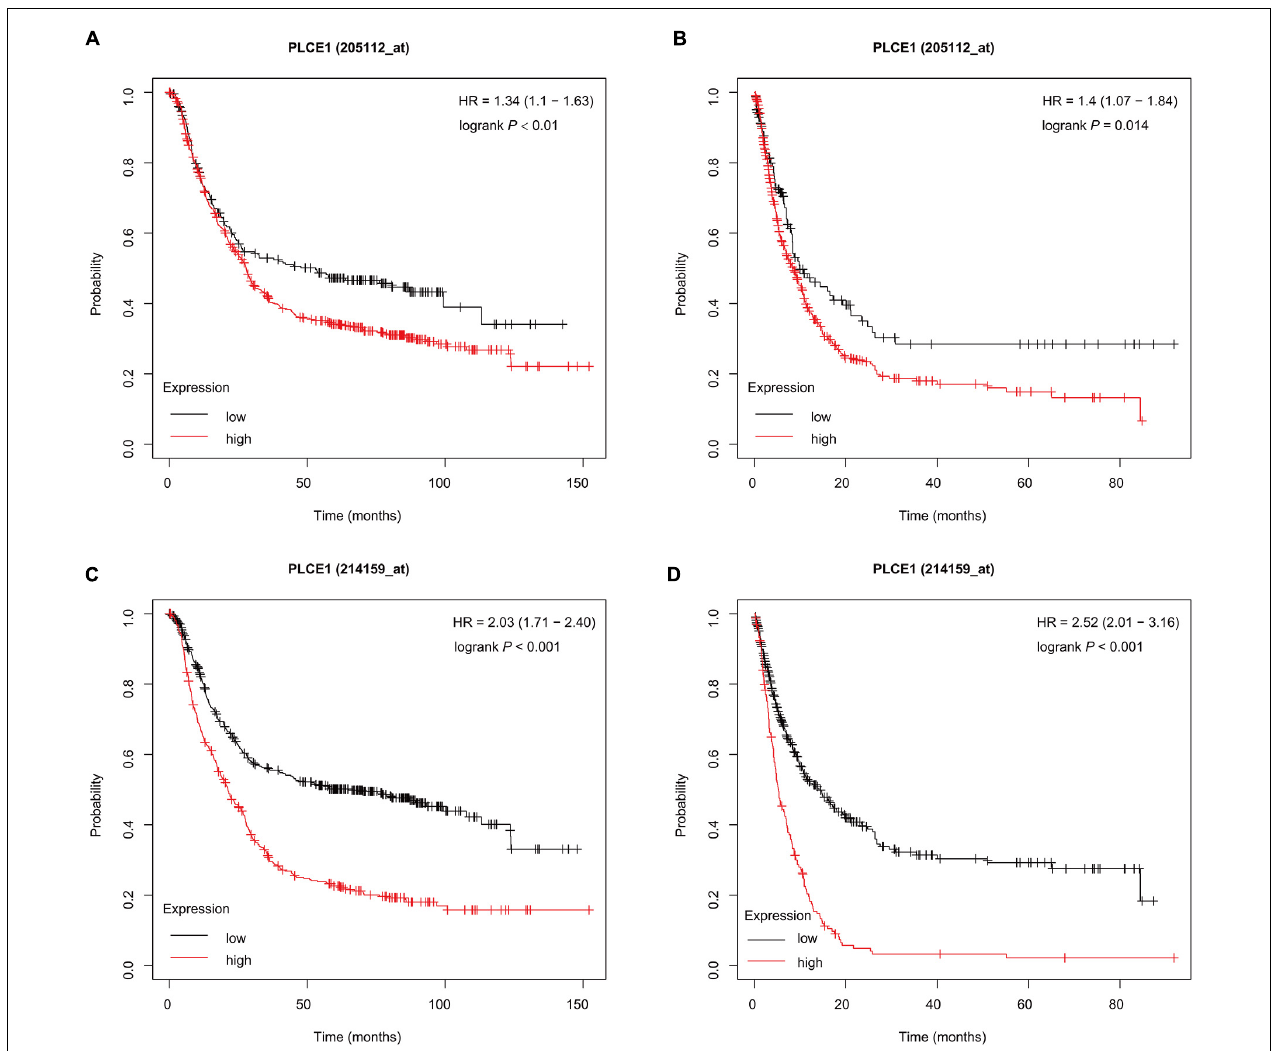
FIGURE 1 | Prognostic characteristic (Kaplan-Meier plotter) of mRNA expression of PLCE1 in gastric cancer patients. The OS curves (A,C) and PFS curves (B,D) comparing patients with high-expression (red) and low-expression (black) of PLCE1 in gastric cancer by two probes (205112 and 214159) were plotted using the Kaplan-Meier plotter database according to the threshold of P -value of <